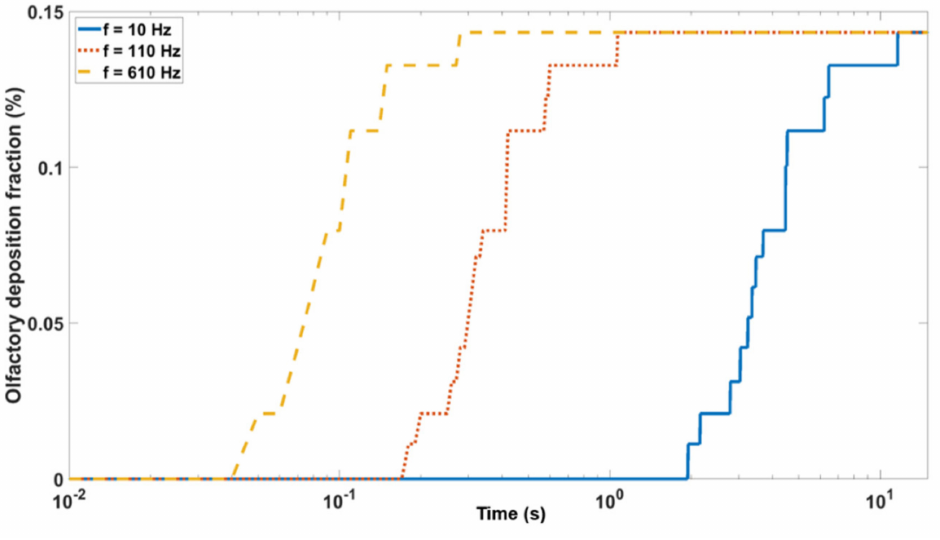
Figure 4. Predicted olfactory deposition at varying